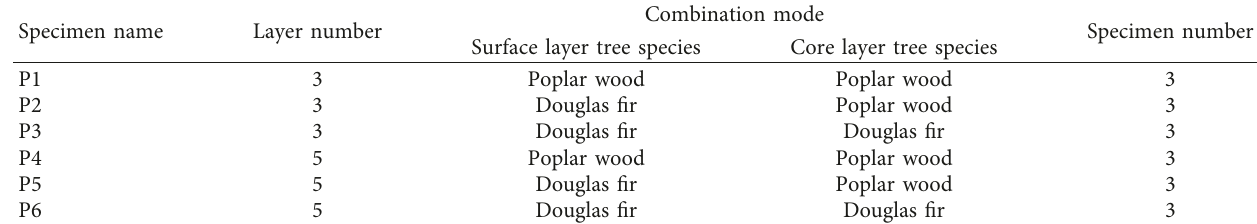
Table 1: Details of tested specimens.